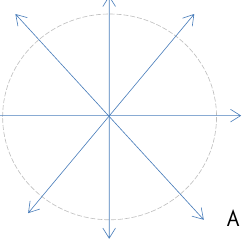
Figure 4. Two different ways to make